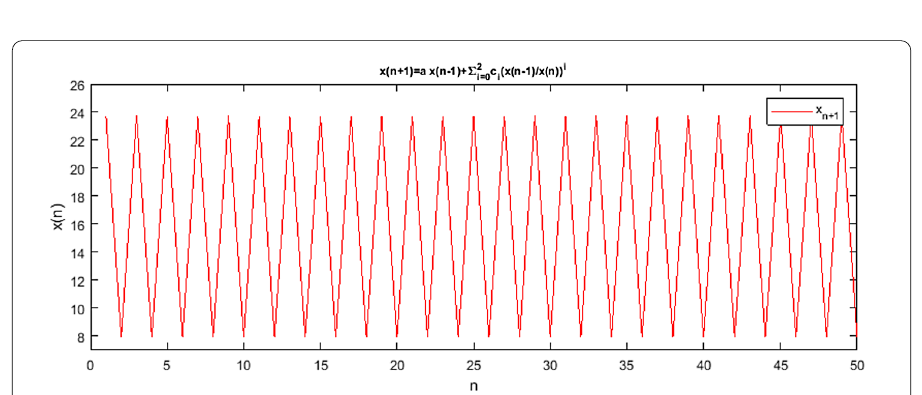
Figure 4 Prime period solution of equation